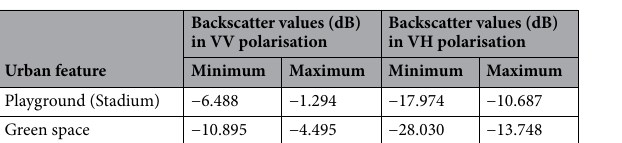
Table 16. Summary of variations in backscatter